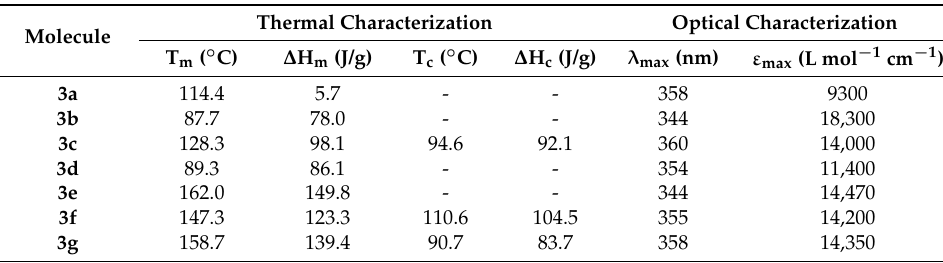
Table 1. Thermal and optical properties of compounds 3a – g . Thermal Characterization Molecule